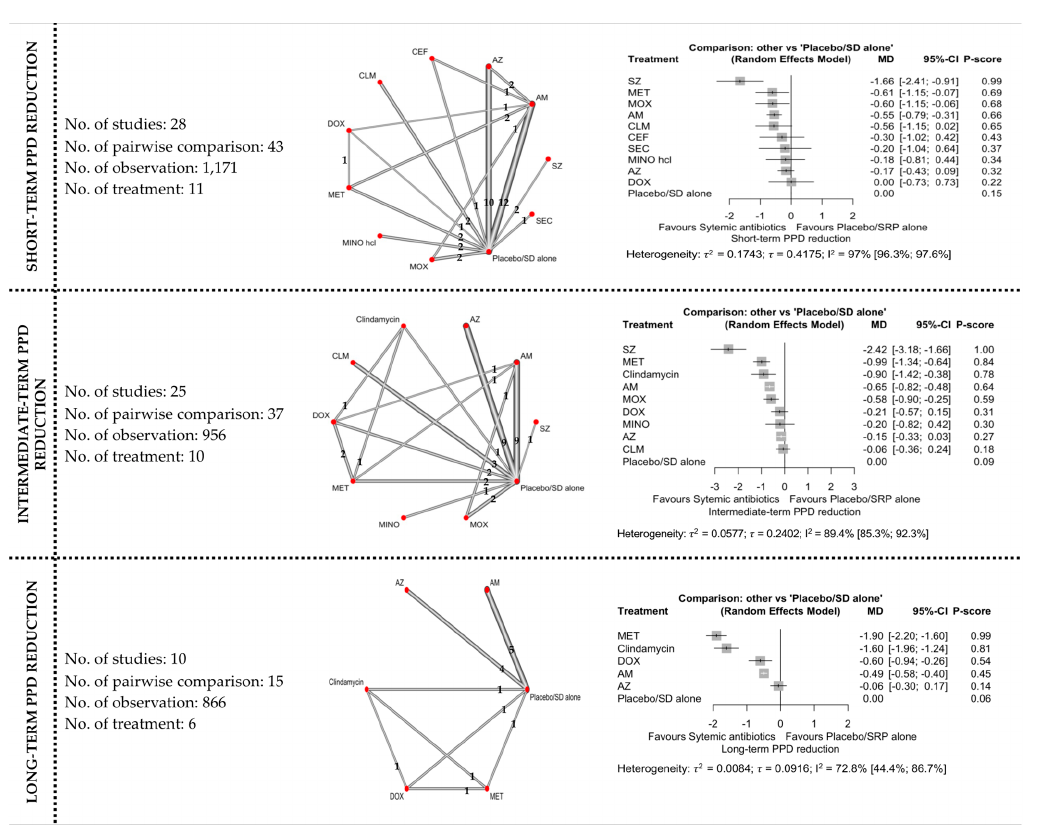
Figure 4. The network and forest plots of the network meta-analysis for PPD reduction. AM: amox- ycillin + metronidazole; AZ: azithromycin; CEF: cefixime; CLM: clarithromycin; DOX: doxycycline; MET: metronidazole; MINO: minocycline; MINO hcl: minocycline hydrochloride; MOX: moxiflox- acin; SEC: secnidazole; SZ: satranidazole; SD: subgingival debridement. For PPD reduction in the intermediate term, out of ten treatments, SZ (P-score: 1.00) was again superior to other antibiotics followed by MET, clindamycin, AMOX+MET, and